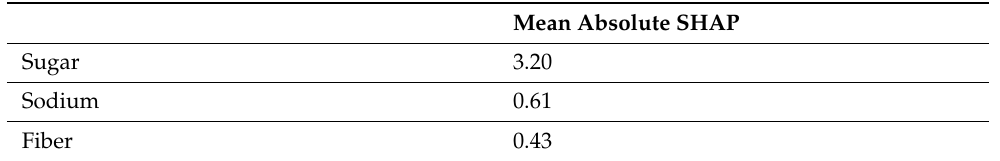
Table 1. Mean absolute average impact of each feature in the XGBoost algorithm’s output magnitude. The value of sugar is the most important factor in predicting added